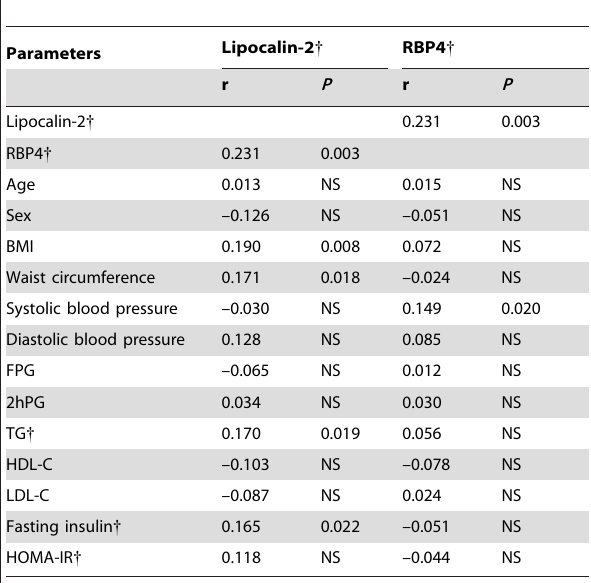
Table 2. Correlation of serum lipocalin-2 and retinol-binding protein 4 levels with other parameters.